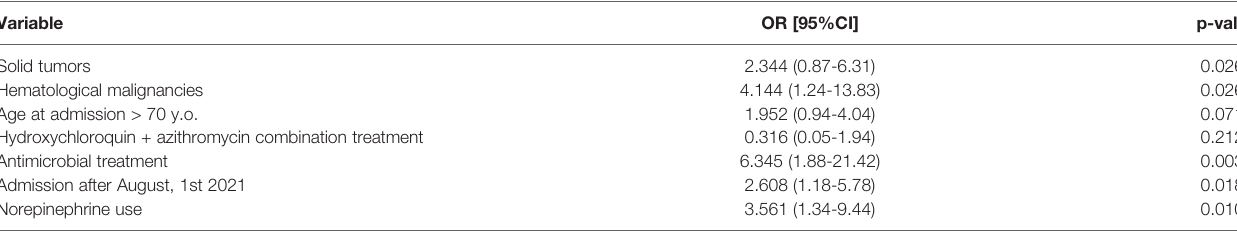
TABLE 5 | Multivariate analysis of parameters associated with